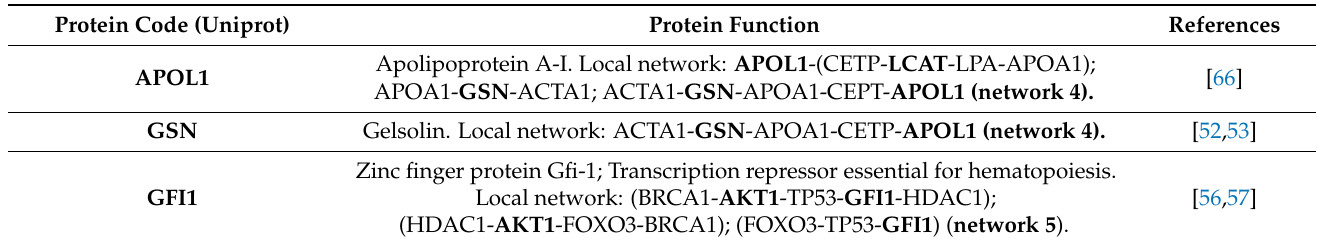
Table 3. References of biological properties and main local interaction description of the panel of 12 proteins selected from those differentially expressed proteins. The network numbers from Figure 5 are reported in brackets. The proteins of the panel are indicated in bold.